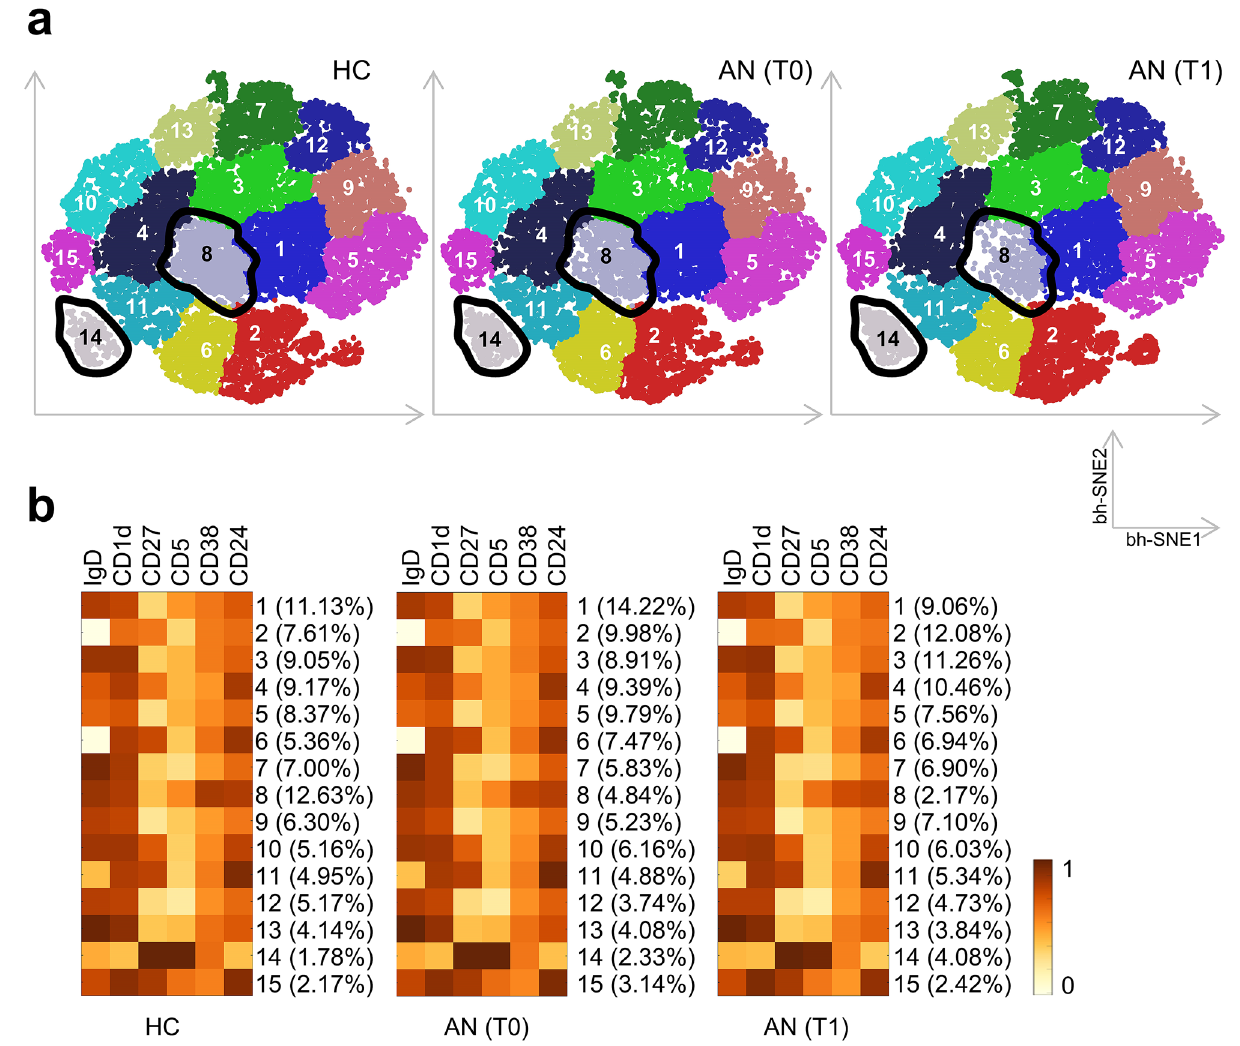
CD19 expression. ( a ) Each graph consists of 10,000 cells merged from the respective group of participants (HC n = 20; patients with AN at T0 n = 24; patients with AN at T1 n = 20). Cells were clustered based on CD45 and CD19 expression using the PhenoGraph algorithm, after using the Barnes-Hut Stochastic Neighbor Embedding (bh-SNE) algorithm to cluster cells with similar expression patterns of CD1d, CD5, CD24, CD27, CD38 and IgD. ( b ) Heatmaps showing the percentages of metaclusters (Y-axis) and mean expression levels of six molecules by individual metaclusters (X-axis) in the different conditions: HC, AN(T0), AN(T1). Cell clusters and heat maps were generated by using the Matlab software (http://www.mathw orks.com/produ cts/matla